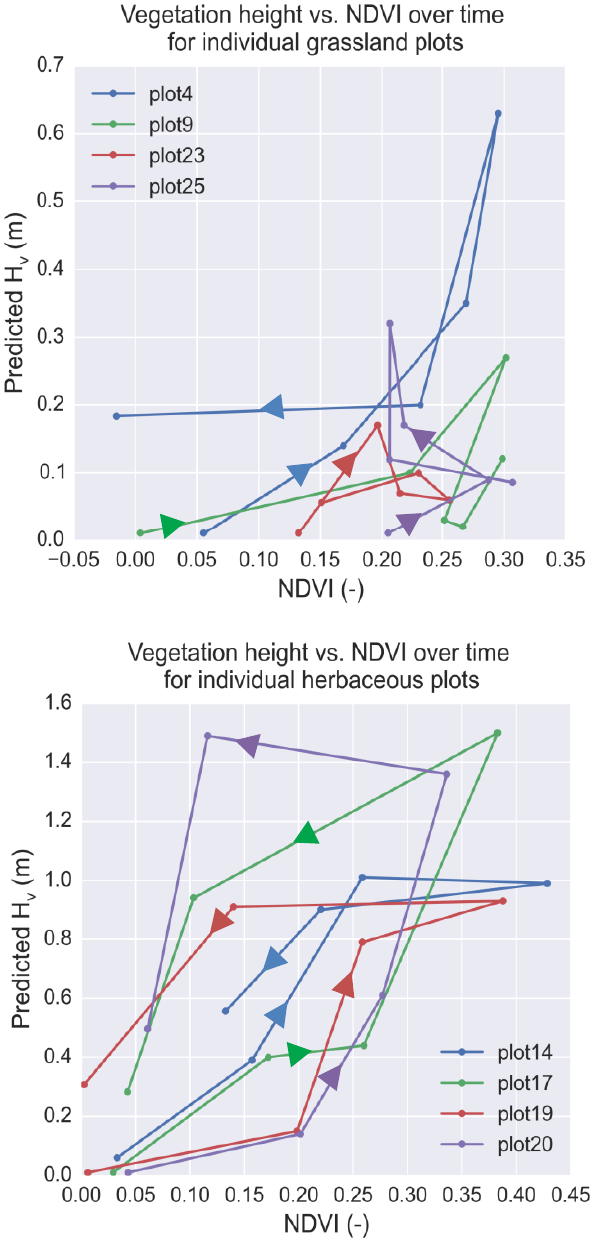
Figure 4. Hysteresis of H and NDVI for grassland v,predicted (top) and herbaceous (bottom) vegetation. Each graph starts in February 2015 and ends in January 2016, arrows indicate direction of